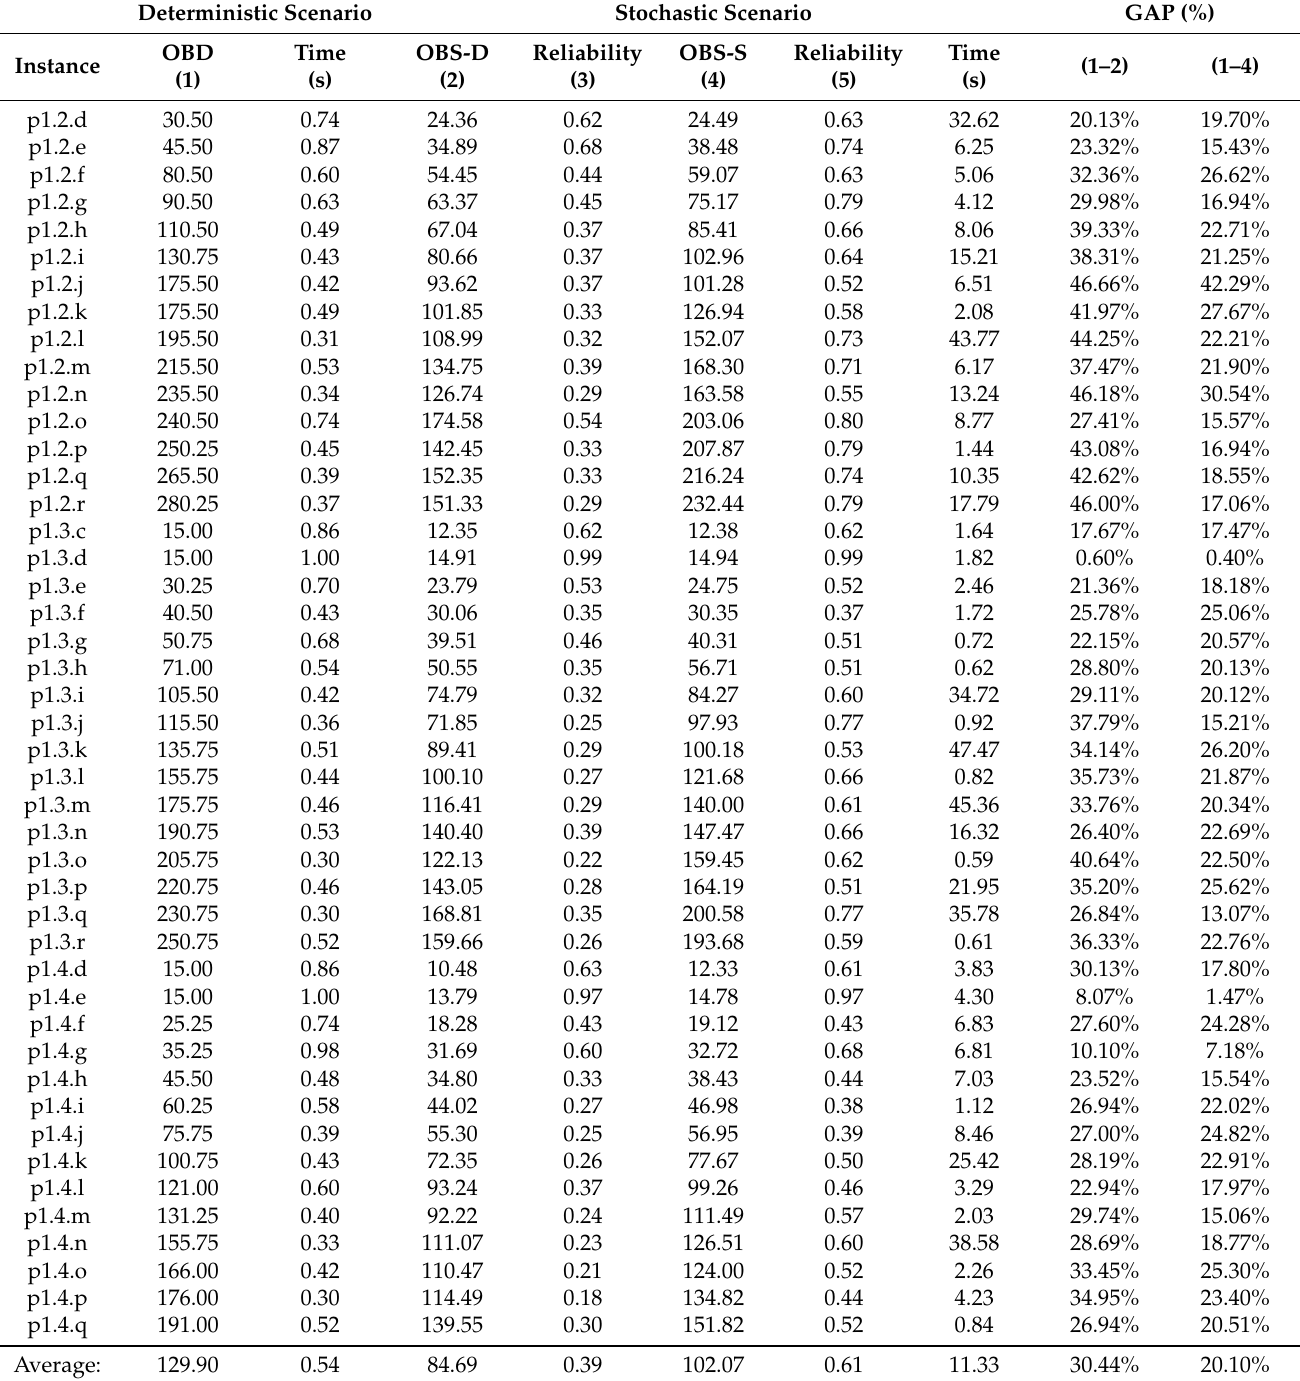
Table 6. Results for p 1 instances in a stochastic scenario with a high variance ( c =